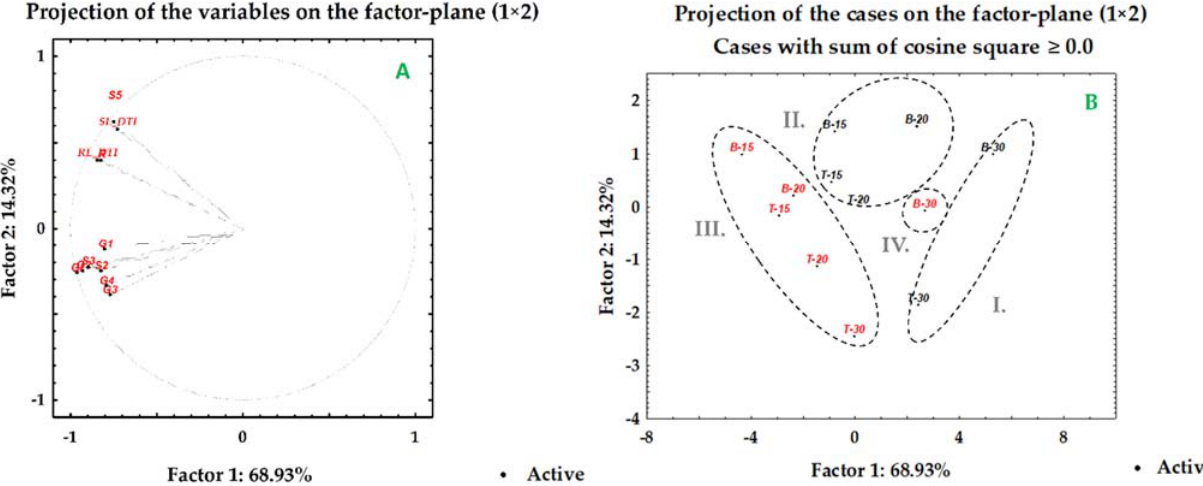
Figure 3. Principal component analysis of data sets of germination percentages (G), germination index (GI), shoot (S) and root (R) lengths, drought tolerance index for shoot (SL_DTI) and root (RL_DTI) lengths under drought (15%, 20% and 30% PEG) and combined (P-15% PEG, P-20% PEG and P-30% PEG) treatments. Genotypes Bernarda (B) and Tena (T). Factor loadings ( A ) and scores ( B ) of first two factors. Numbers beside each variable represent the day of treatment. Red marks present high voltage electrical discharge (HVED) pretreatment.